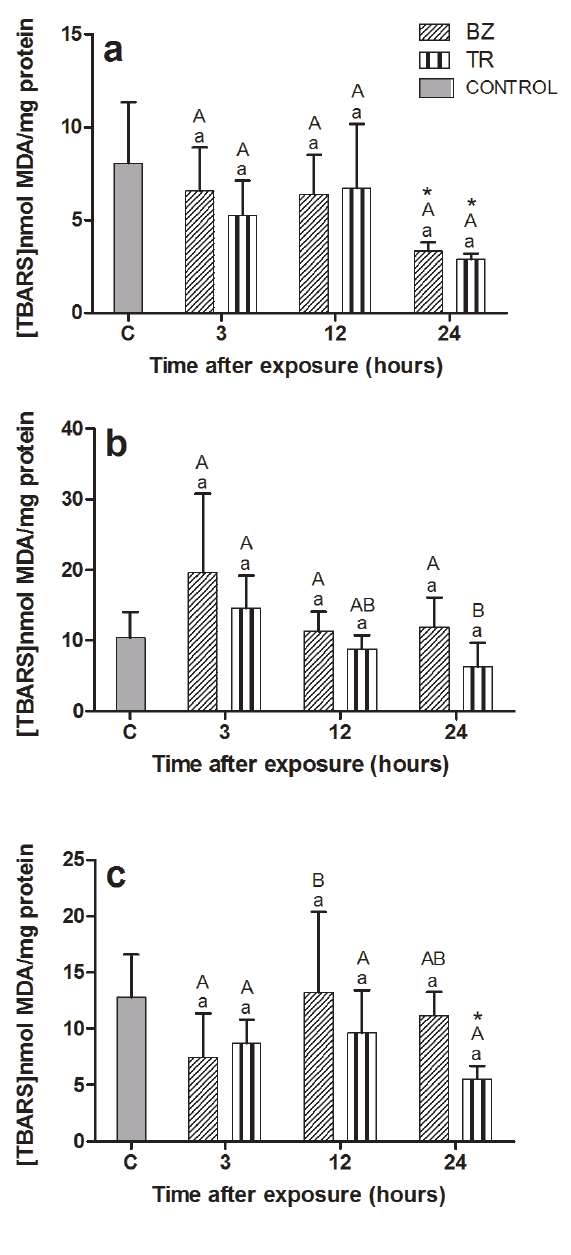
Figure 3 - Levels of lipid peroxidation (TBARS) of gills ( a ), liver ( b ) and brain ( c ) of juvenile tambaqui, Colossoma macropomum anesthetized with benzocaine or tricaine. Values are expressed as means ± SD. Different lowercase letters indicate significant differences between treatments (anesthetics) within sampling time; different capital letters indicate significant differences within treatment over time; asterisk indicates significantly different from control (C) (n = 10,